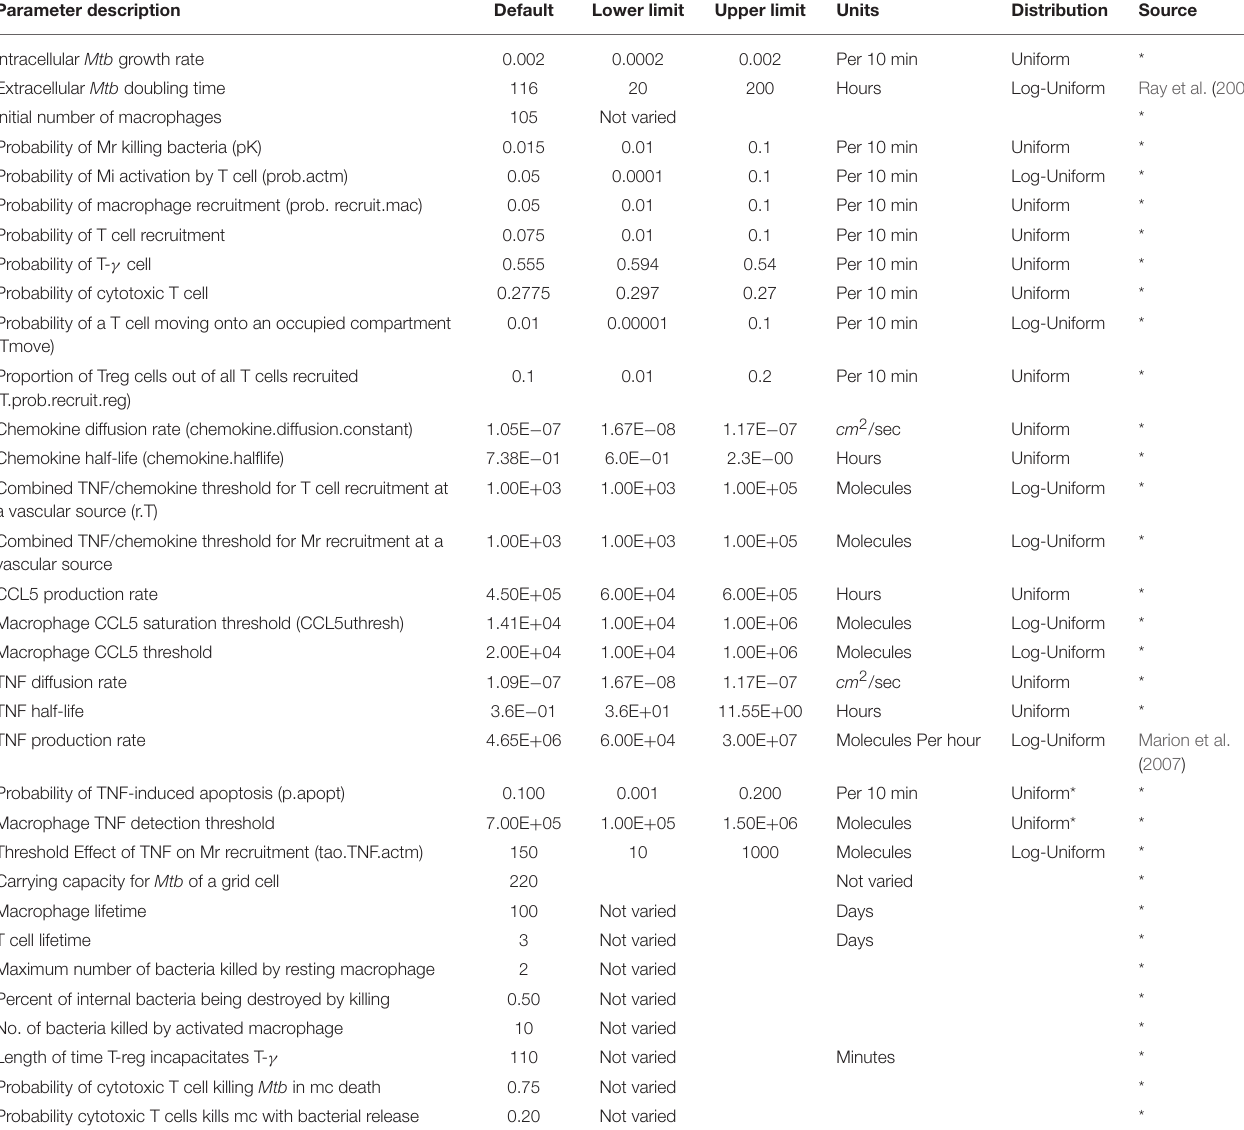
TABLE 2 | Model parameters used for the standard and integrated